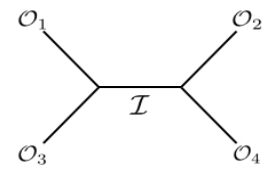
Figure 2 . Identity exchange in this channel accounts for full four point